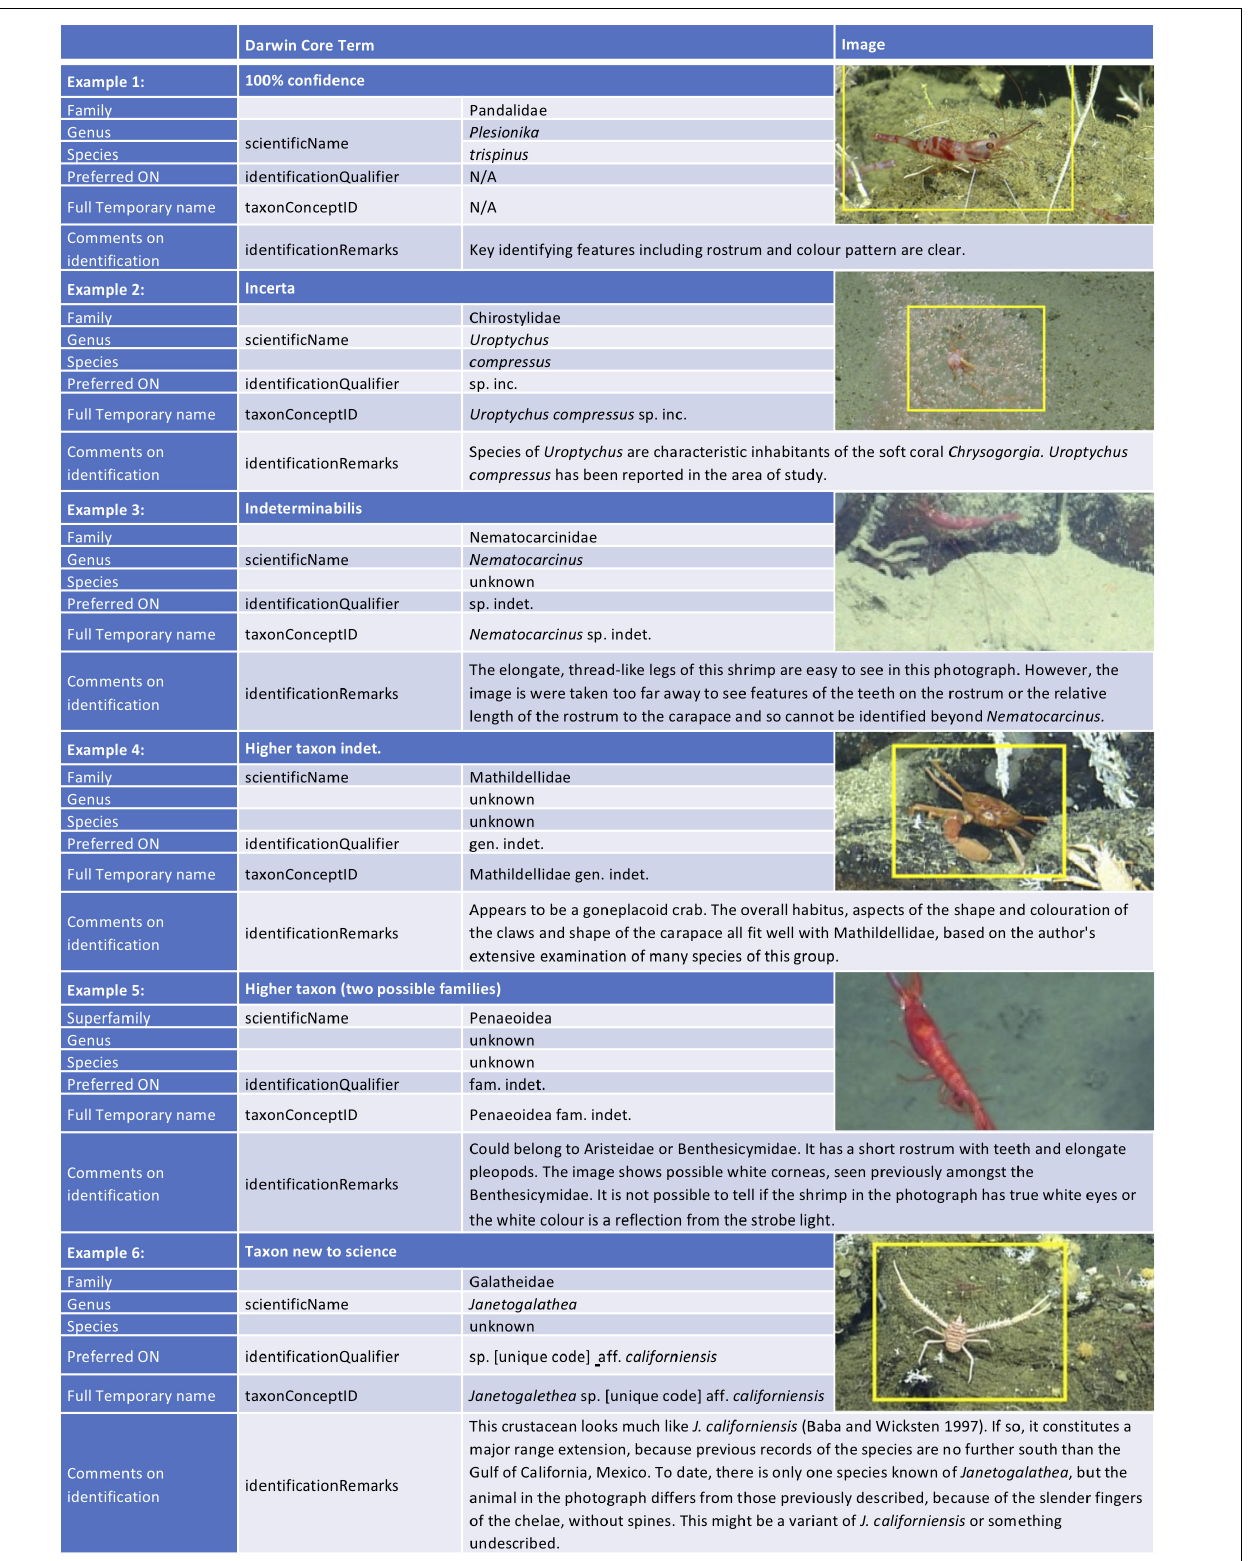
FIGURE 2 | Example usage of the recommended ON signs for image-based identifications and how to format the identification for input to online databases such as OBIS/GBIF in Darwin Core format. Examples images and identifications are provided from Arnés-Urgellés et al. (2020).